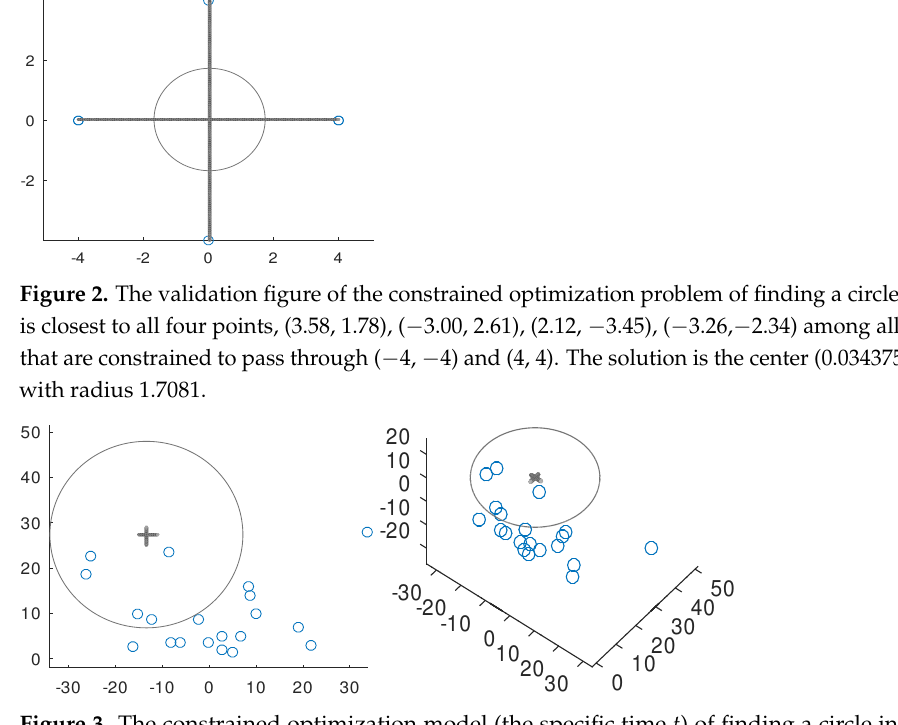
Figure 3. The constrained optimization model (the specific time t ) of finding a circle in 2D that is closest to all cell phone 20 position points among all the circles that are constrained to pass through (5, 8) and ( − 5, 2). The solution is the center ( − 13.4130, 27.355) with radius 20.582.